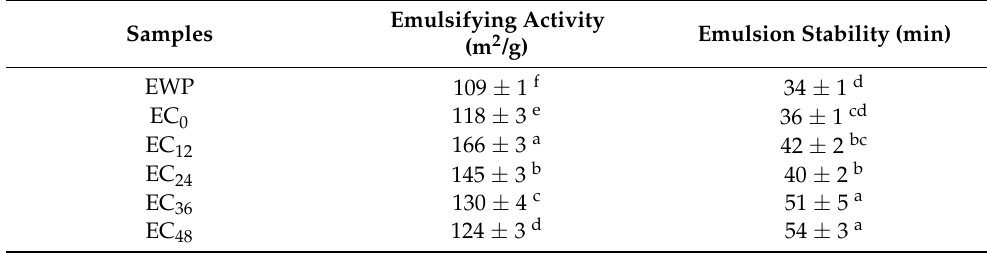
Table 3. Emulsifying activity and emulsion stability of the